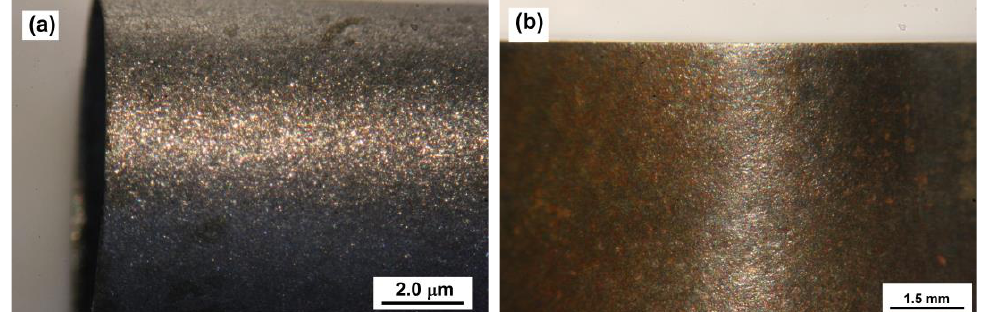
Figure 12. Optical micrographs of nontreated ( a ) and treated corrosion specimen ( b ) surfaces upon exposure to synthetic oil-field-produced water in the presence of sand particles at 2440 rpm for 24 hours.